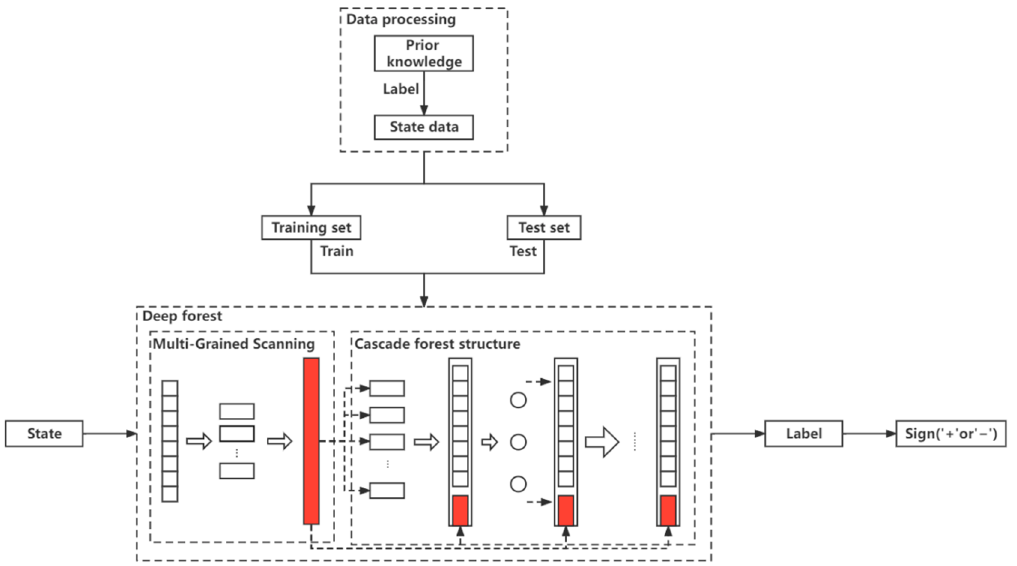
Figure 8. The process of training a DF classifier.